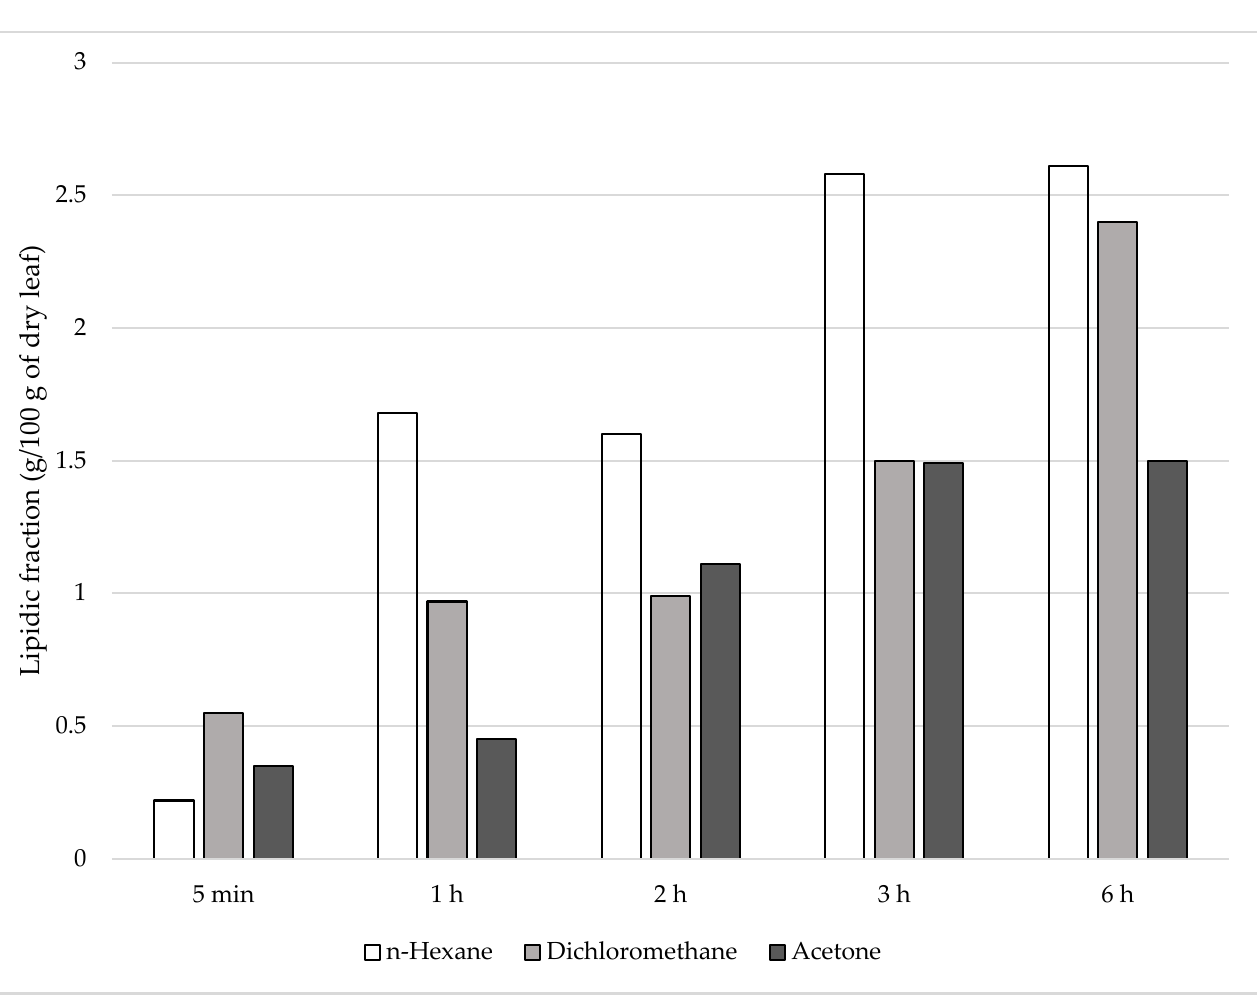
Figure 1. Lipidic fraction obtained from extraction of Q. suber leaves with solvents with different polarity indices with different extraction times.